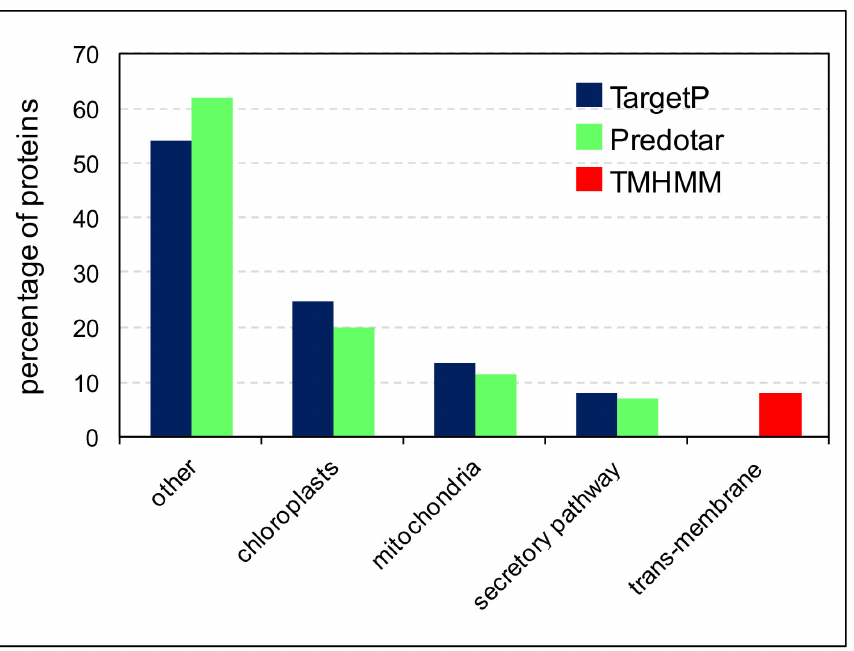
Figure 4. Prediction of the sub-cellular localization of the proteins presumed to be contaminants in cell wall proteomes. The predictions were made with TargetP, Predotar or TMHMM. “Trans-membrane” stands for trans-membrane